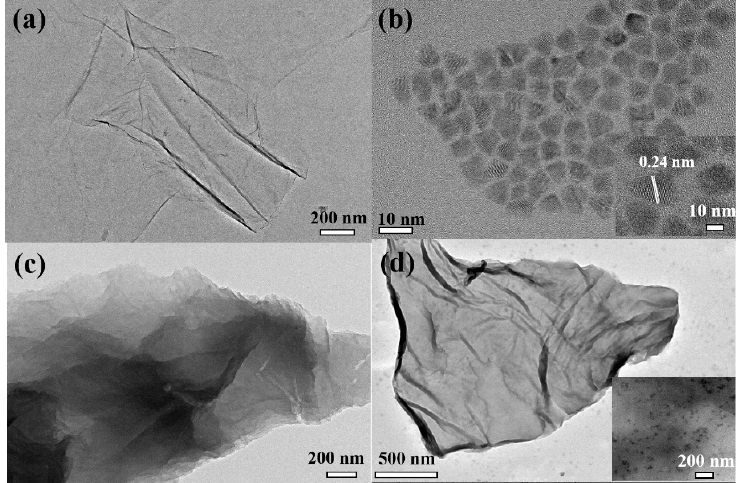
Figure 7. TEM micrograph of GO ( a ), CdSe/ZnS QDs ( b ), GO-CD ( c ) and fluorescence hybrid ( d ).